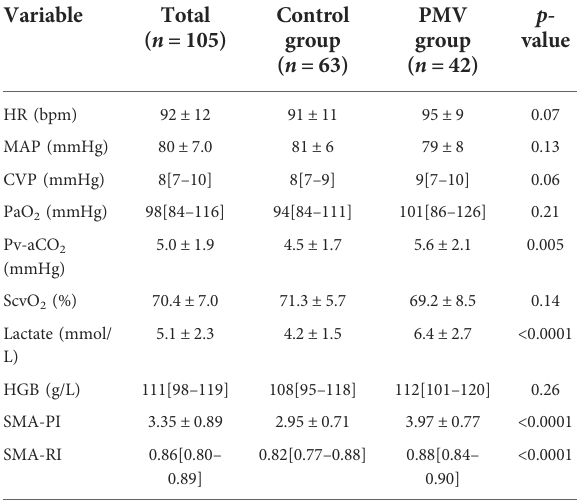
TABLE 2 The hemodynamic and Doppler variables at admission of the patients after cardiac valve surgery.